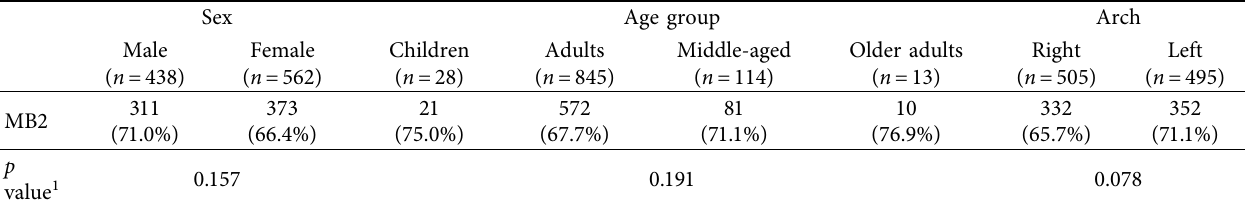
Table 6: Prevalence of a second canal in the mesiobuccal root (MB2) according to sex, age group, and dental arch of the patient